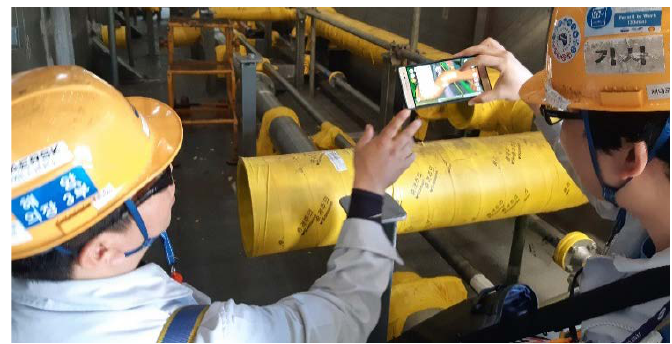
Figure 19. Effective fabrication support using the AR system.